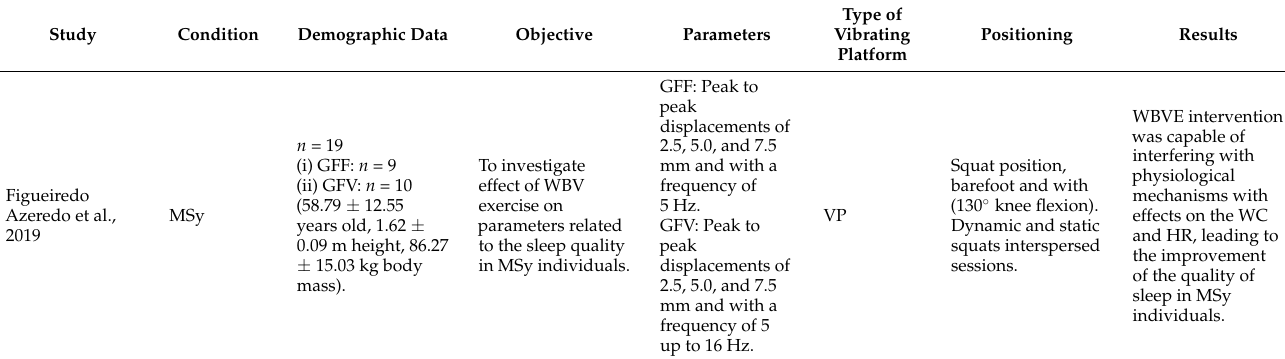
Table 6. Different populations submitted to WBV exercise, with symptoms also observed in the COVID-19 patients: quality of